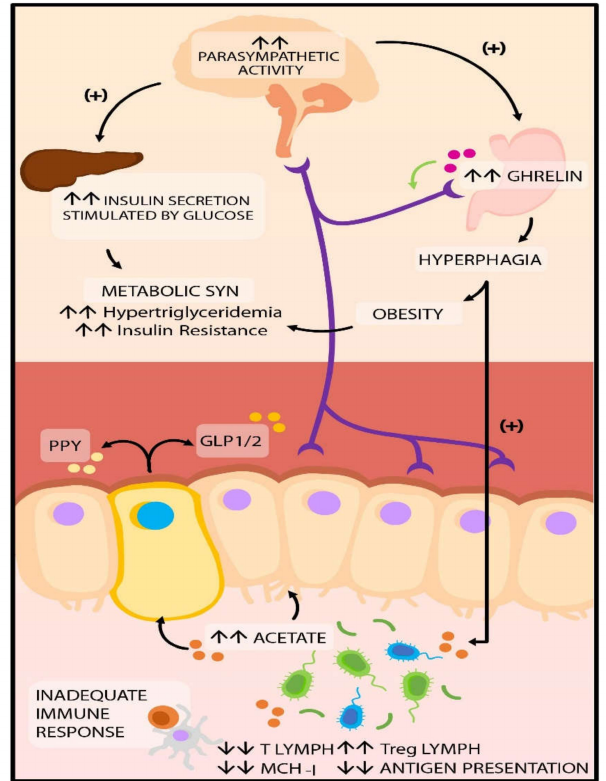
Figure 3. Potential regulation of hunger perception and satiety. In dysbiosis SCFA production, specifically, acetate allows the activation of the parasympathetic nervous system, which increases ghrelin secretion and, therefore, hyperphagia. It also enables the secretion of insulin, favoring the development of obesity, hyperlipidemia, and insulin resistance. Abbreviations: SCFA: short-chain fatty acids; GLP1 / 2: glucagon-like peptide 1 / 2; PPY peptide